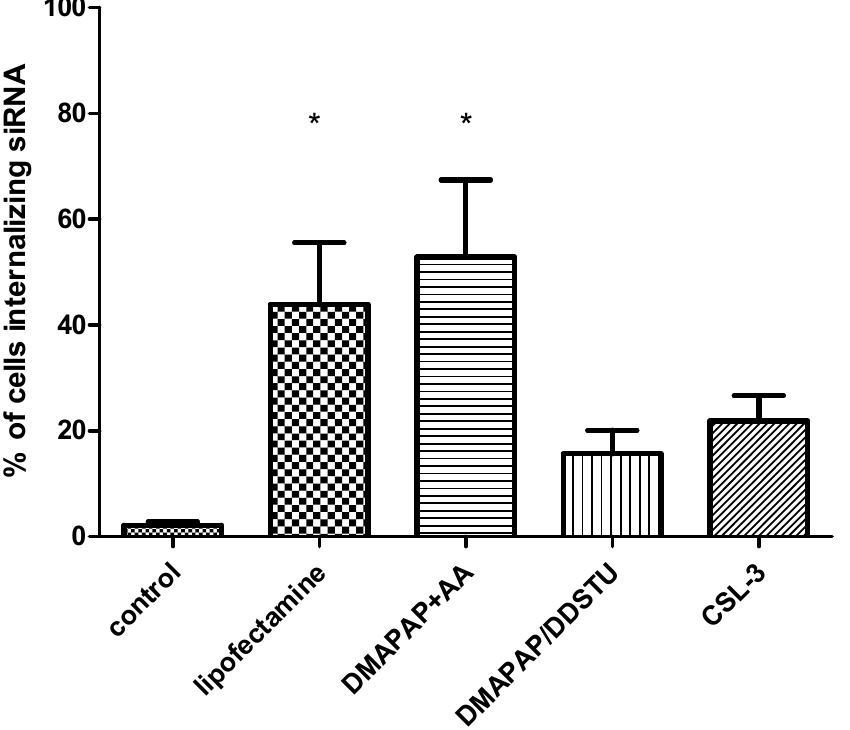
Figure 2. Percentage of observed cells internalizing siRNA. Results are expressed as mean ± standard error from values of experiments realized on cells collected from four placentae. Kruskal-Wallis Dunn’s multiple comparison test: lipofectamine vs. control, p < 0.05 (*); DMAPAP+AA vs. control, p < 0.05 (*); DMAPAP/DDSTU and CSL-3 vs. control, non-significant.